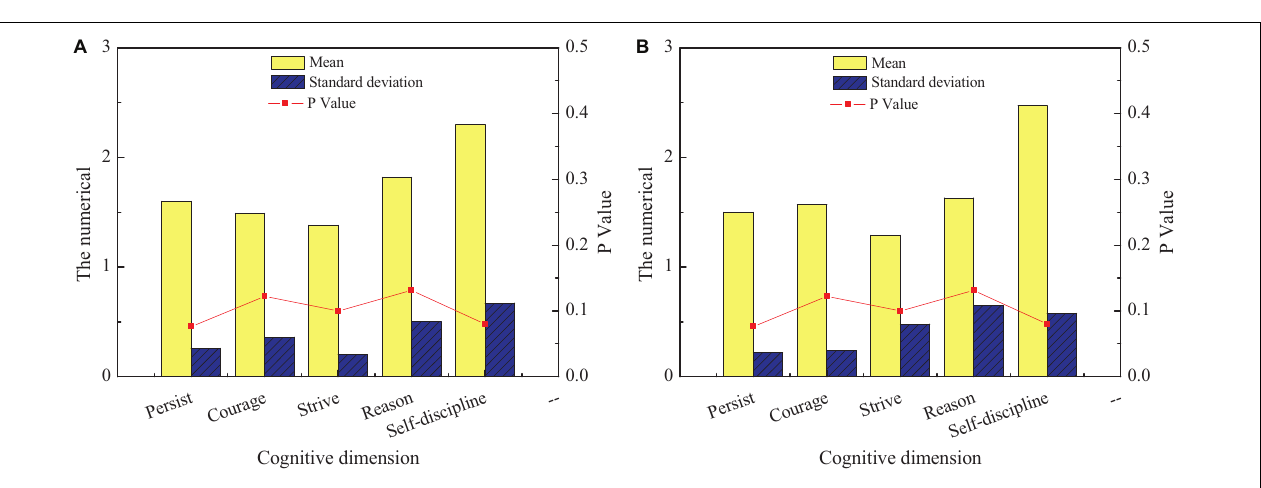
seniors. This phenomenon may be caused by the different entrepreneurial time between seniors and